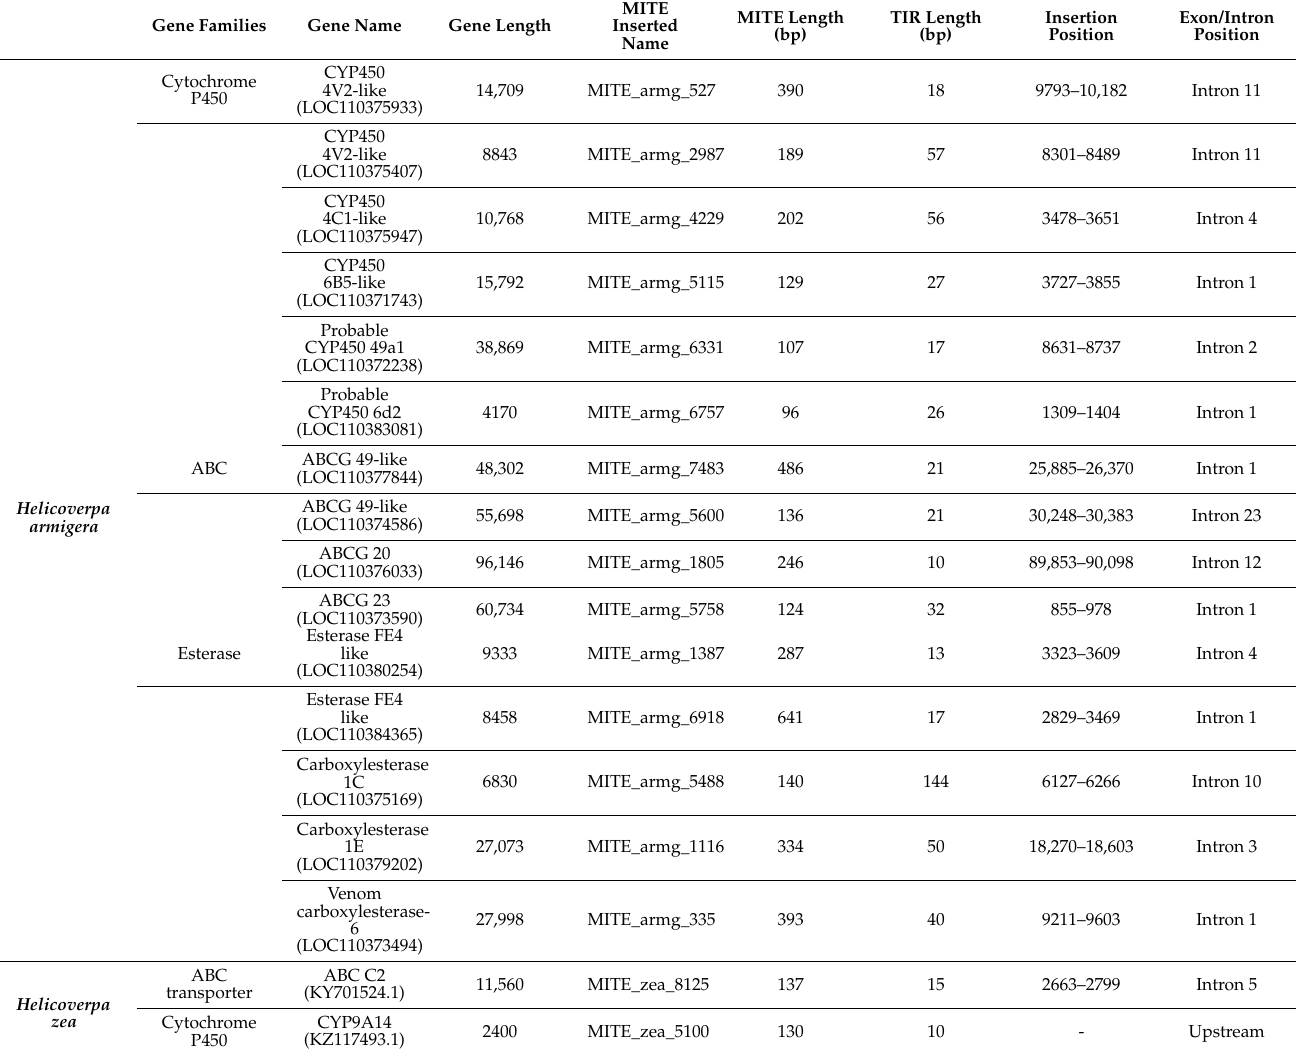
Table 3. MITE insertions in defensome genes of H. armigera and H. zea genomes. Gene